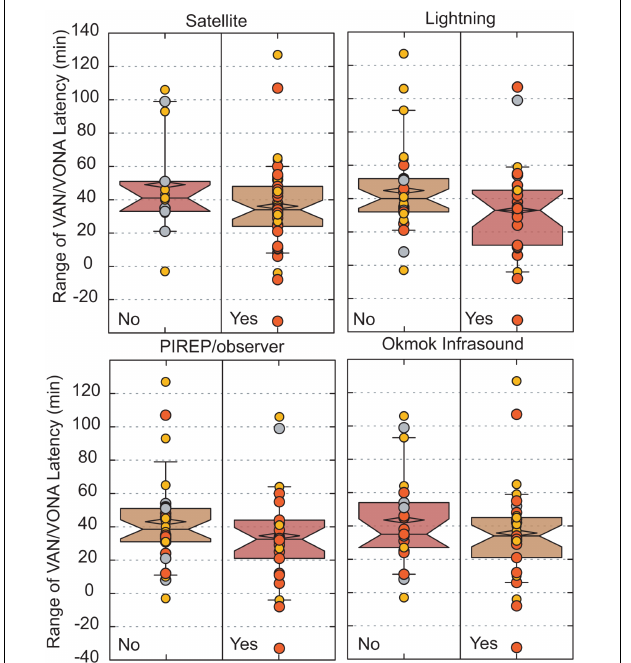
of individual data streams on latency of notifications for those events 6–70 for which notifications were issued. In each case, notched center shows median, bottom and top of box show 25th and 75th percentiles, and whiskers show 10th and 90th percentiles. Diamonds show